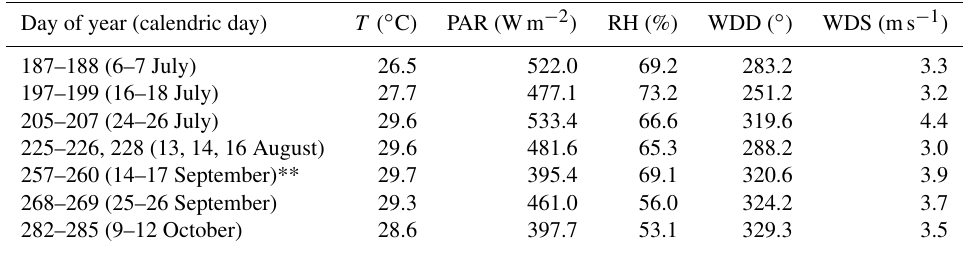
Table 1. Measurement periods and corresponding daytime mean of meteorological parameters used for the analyses ∗ including temperature ( T ), photosynthetically active radiation (PAR), relative humidity (RH), wind direction (WDD) and wind speed